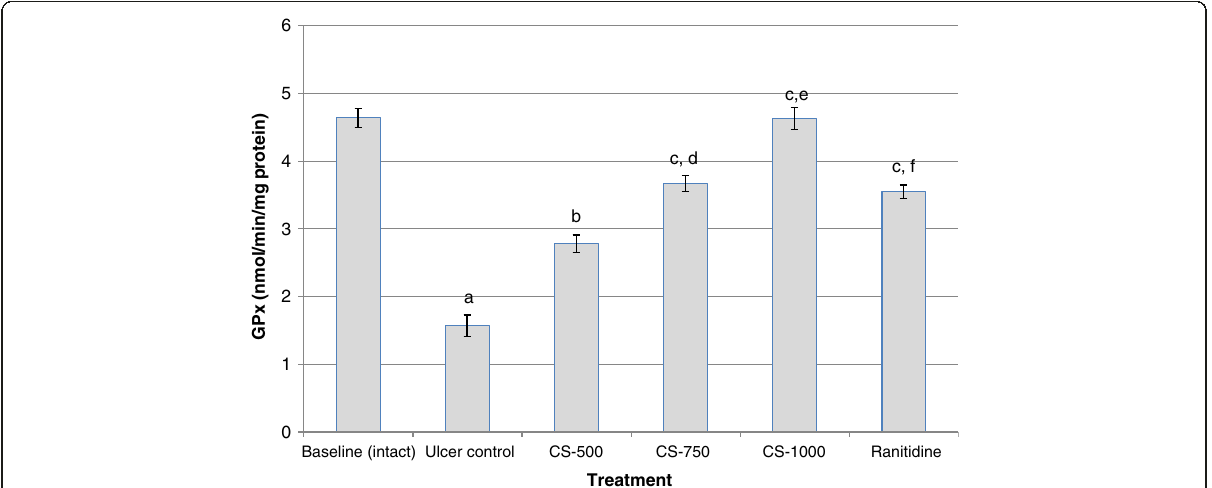
Figure 5 Effect of C. sieberiana (CS) plant extract on mucosal glutathione peroxidase activity in F 344 rats. a p<0.001 compared with baseline (intact); b p<0.01 compared with ulcer control; c p<0.001 compared with ulcer control; d p<0.01 compared with CS-500; e p<0.05 compared with CS-750; f p<0.01 compared with CS-1000; Values are Mean ± SEM of 6 animals. Statistical significance was determined by one-way analysis of variance (ANOVA) followed by Dunnett ’ s post hoc t